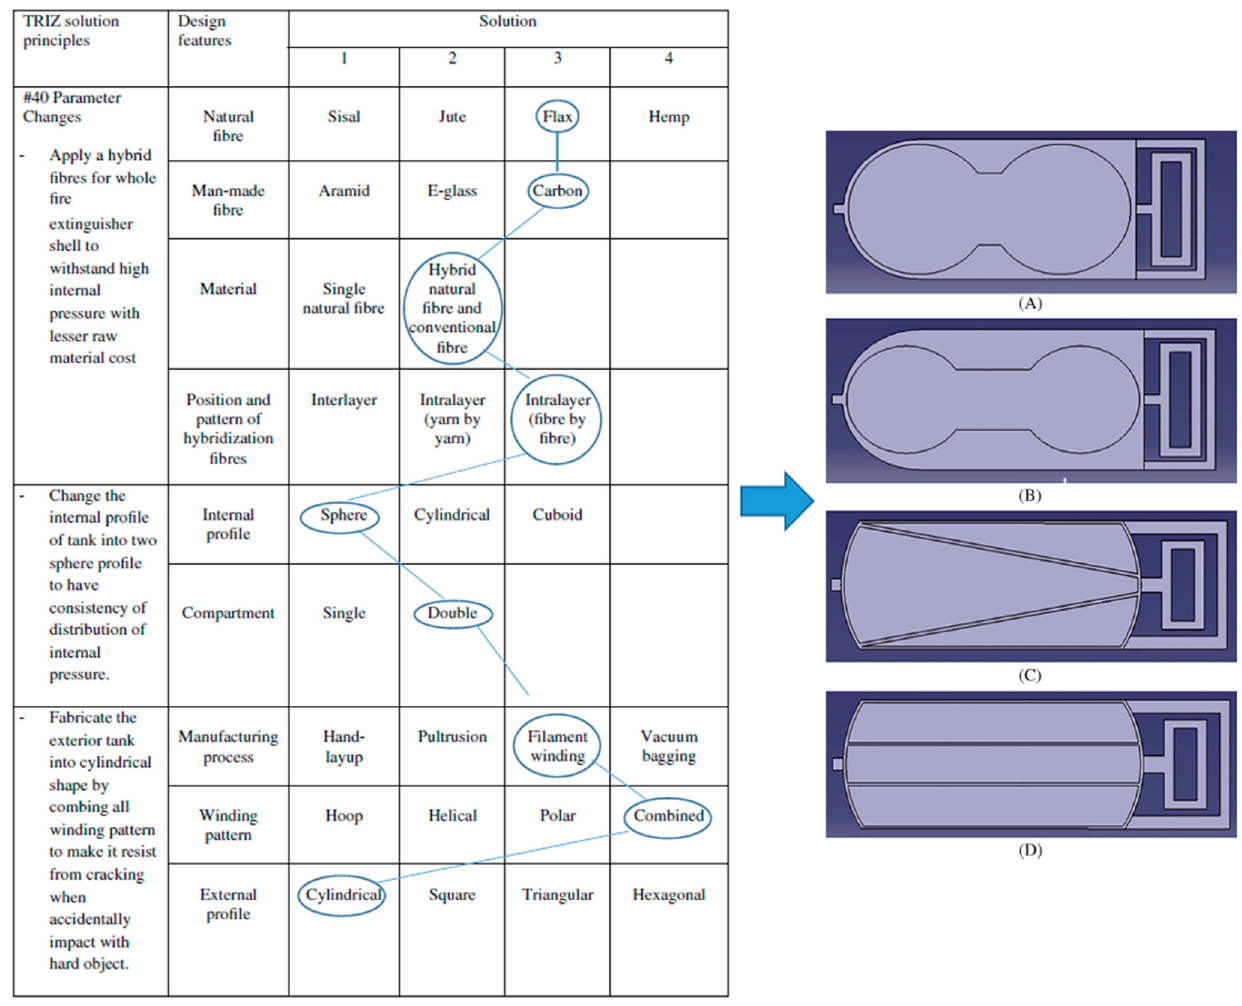
Figure 14. Morphological chart that shows the design features selection of a fire extinguisher prior to development of conceptual designs A, B, C and D. Reproduced with copyright permission from Asyraf et al. [76].